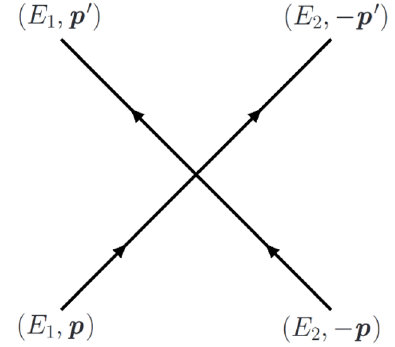
Figure 2 . The diagram encoding the leading tidal effect in the EFT in eq.